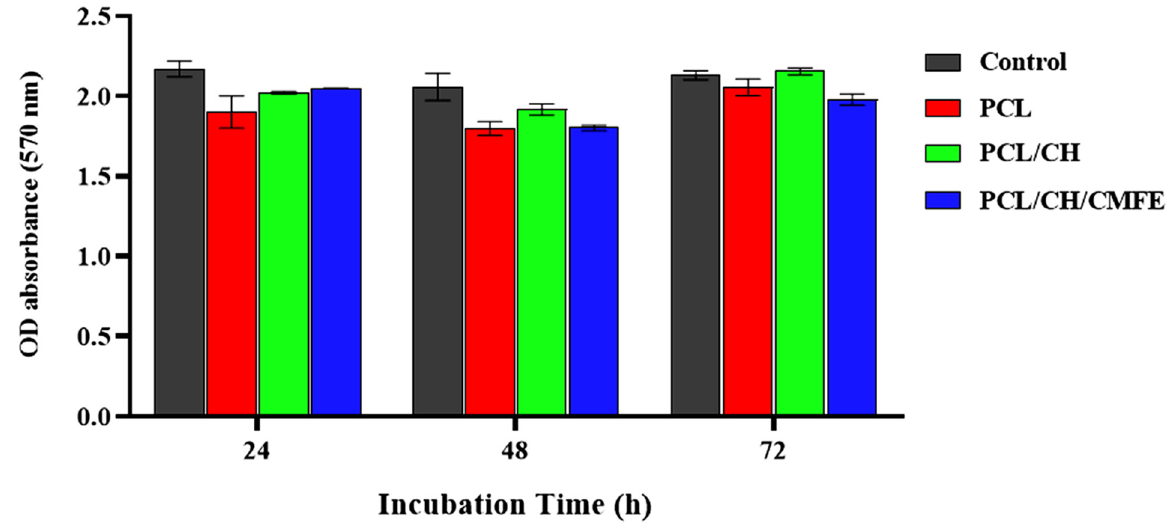
Figure 8. Viability test results (%) for fibroblast cell lines cultured for 24, 48, and 72 h with clear PCL, PCL/CH, and PCL/CH/CMFE mats. The mean and standard deviation are shown as bars (n = 5).